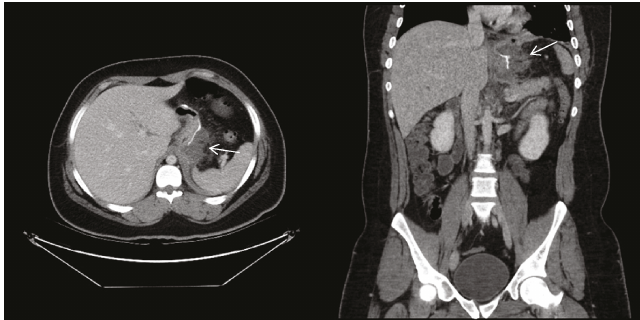
Figure 1: Computed tomographic scan showing perigastric collection adjacent to gastroesophageal junction and along sleeve gastrectomy sutures. Arrow: perigastric collection.